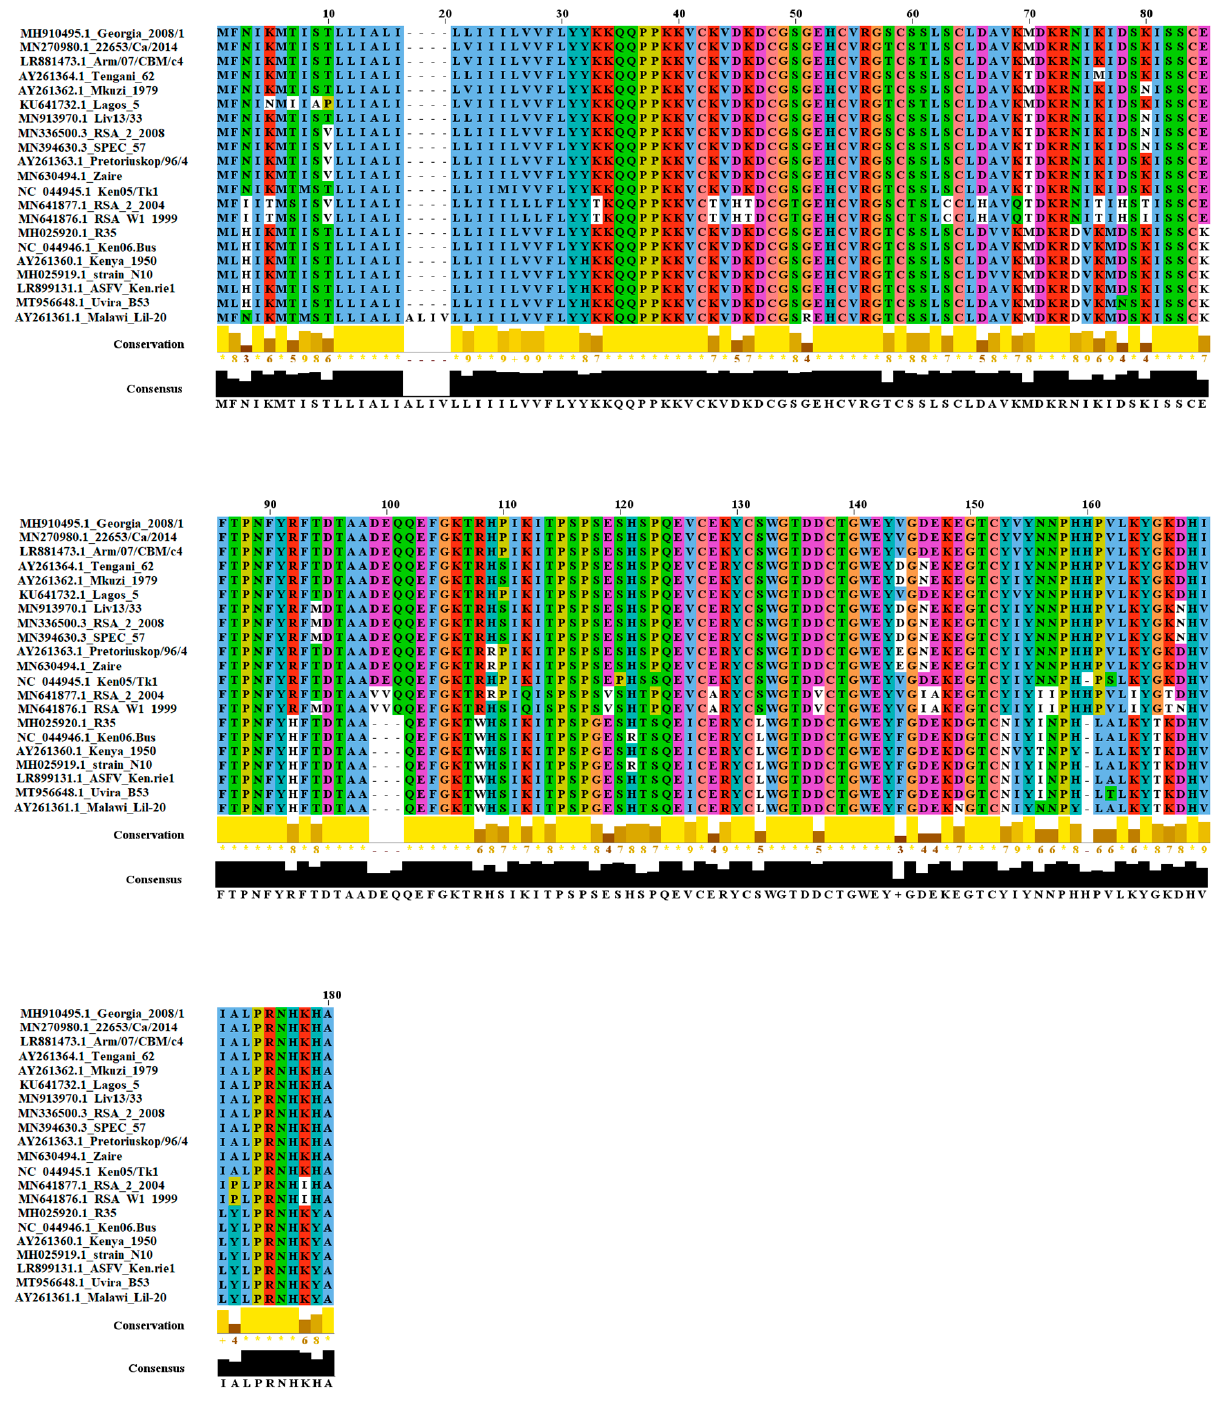
Figure 1. Amino acid diversity of protein p22. Twenty-one protein sequences representing the amino acid diversity of protein p22 (KP-177-R gene) of ASFV within the GenBank database were used to conduct this alignment. To assess the nature of the replacements at multiple residues, conservation scores based on the biological properties of each amino acid were included, the lower scores being associated with more divergent replacements. Symbols (*) indicate residue conservation or (+) replacement for an amino acid with similar properties. Analysis was conducted on Jalview software version 2.11.1.3, using the ClustalW algorithm sequence alignment of the indicated ASFV isolates of viral protein PK177R. Matching residues are represented as dots. The degree of conservation is below the alignment.